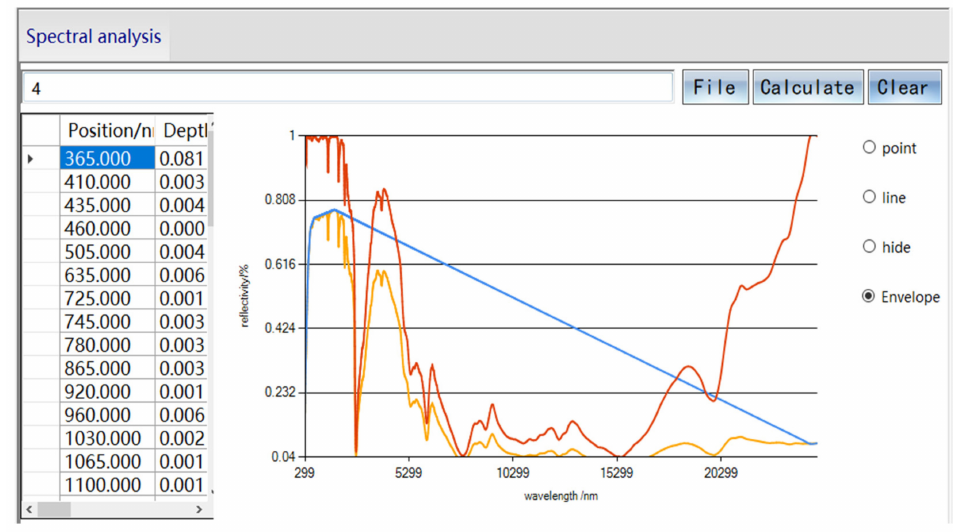
Figure 7. Data analysis of RockSL. The target curve is displayed with yellow colour, the envelope of the spectrum is shown with blue colour and the continuum removed (CR) spectra using the convex hull algorithm is shown with orange colour.